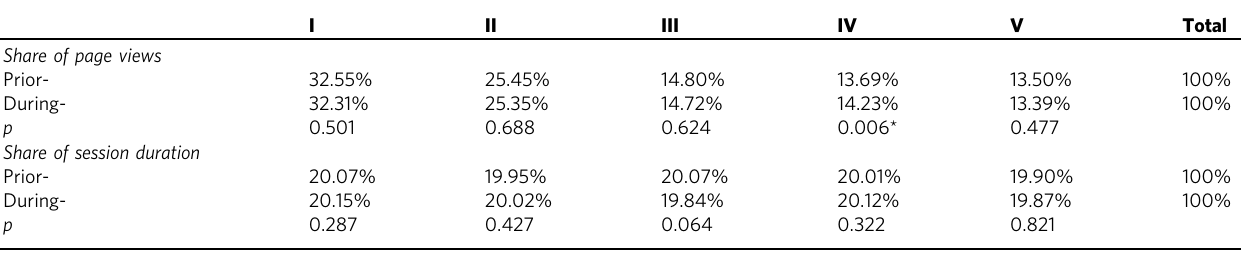
Table 2 Share of page views (above) and session duration (below) of the respective issue areas 8 weeks prior- and after the beginning of the lockdown (Germany, Austria and Switzerland).